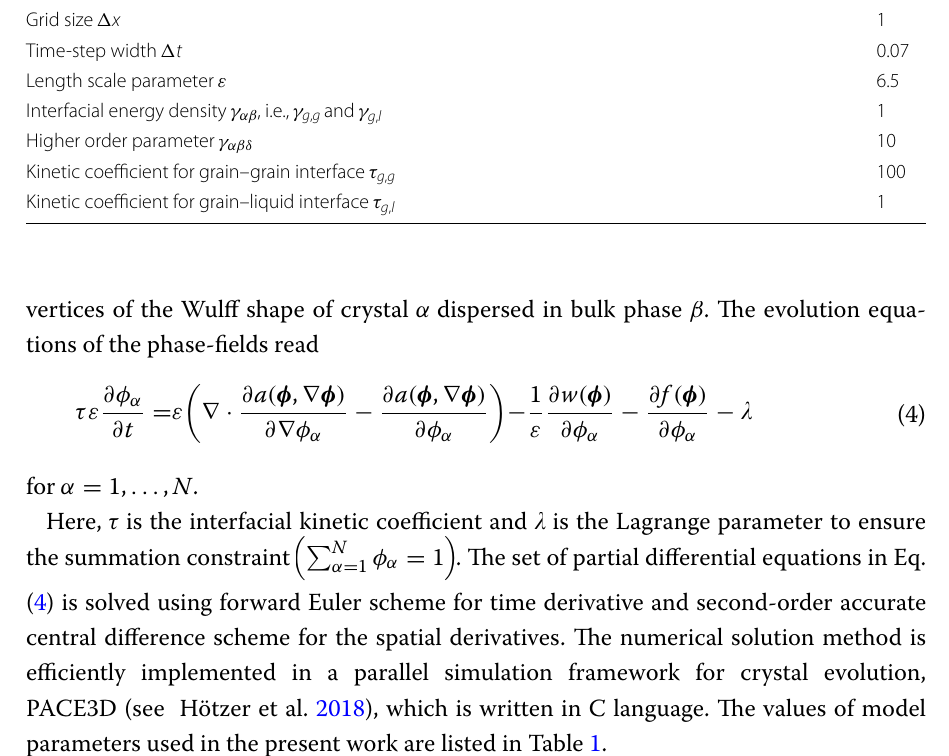
Table 1 Values of phase-field model parameters used in simulations Model parameters Value Grid size (cid:31)